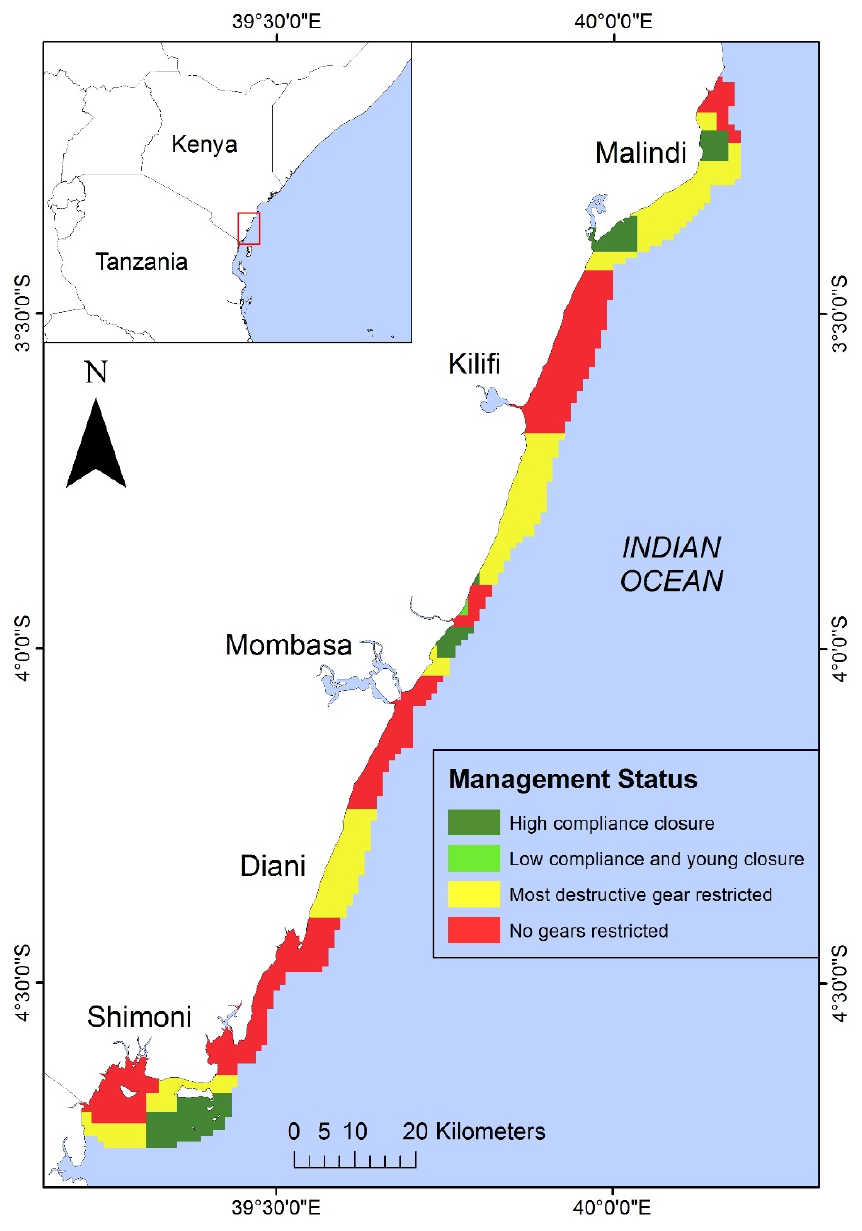
Figure 1. Map of the distribution of the four fisheries management categories in place along the Kenyan coast.